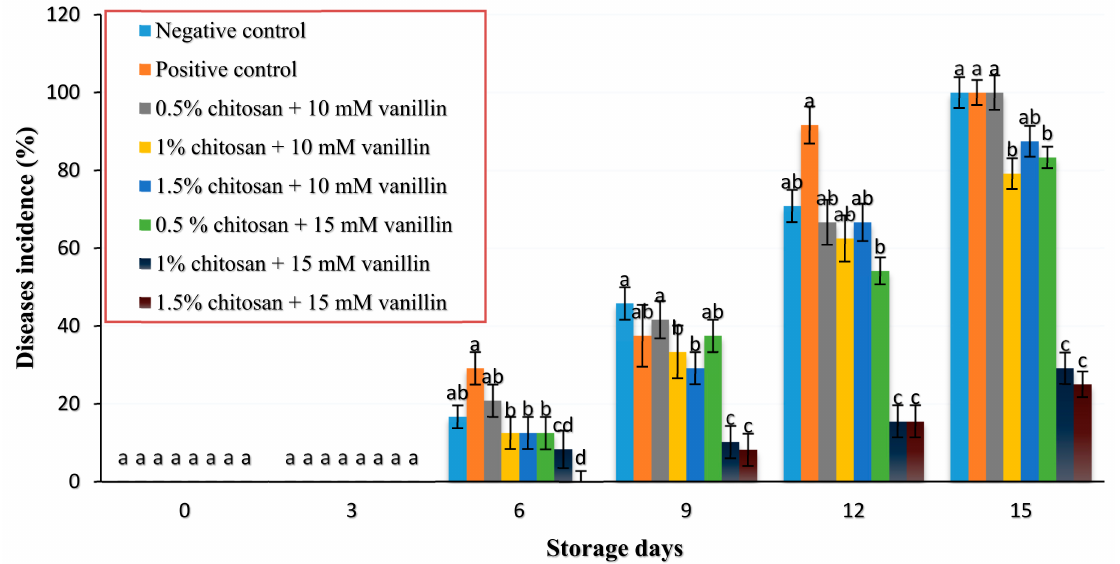
Figure 3. Effects of coating treatment on disease incidence of Fusarium oxysporum in tomato fruit stored for 15 days at 26 ± 2 ◦ C and 60 ± 5% relative humidity. Mean values in a column followed by different letters for each storage day differed significantly by LSD at p ≤ 0.05. Vertical bars indicate standard error of means. Prior to analysis, the data were square root transformed, while non-transformed means are shown ( n =